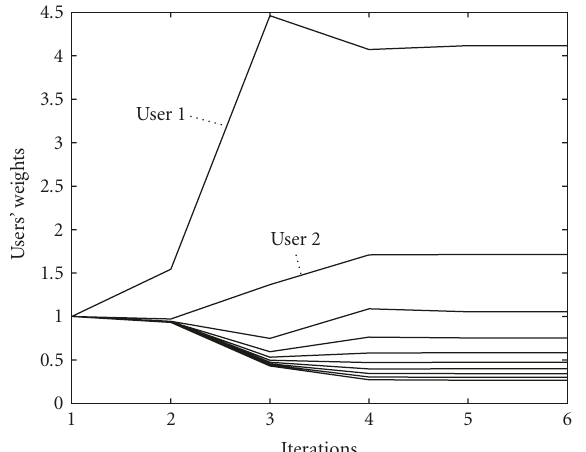
Figure 8: Convergence of the weight vectors in the 10-users channel using a conventional Gauss-Newton method. The average SNR is ρ = 10 dB.